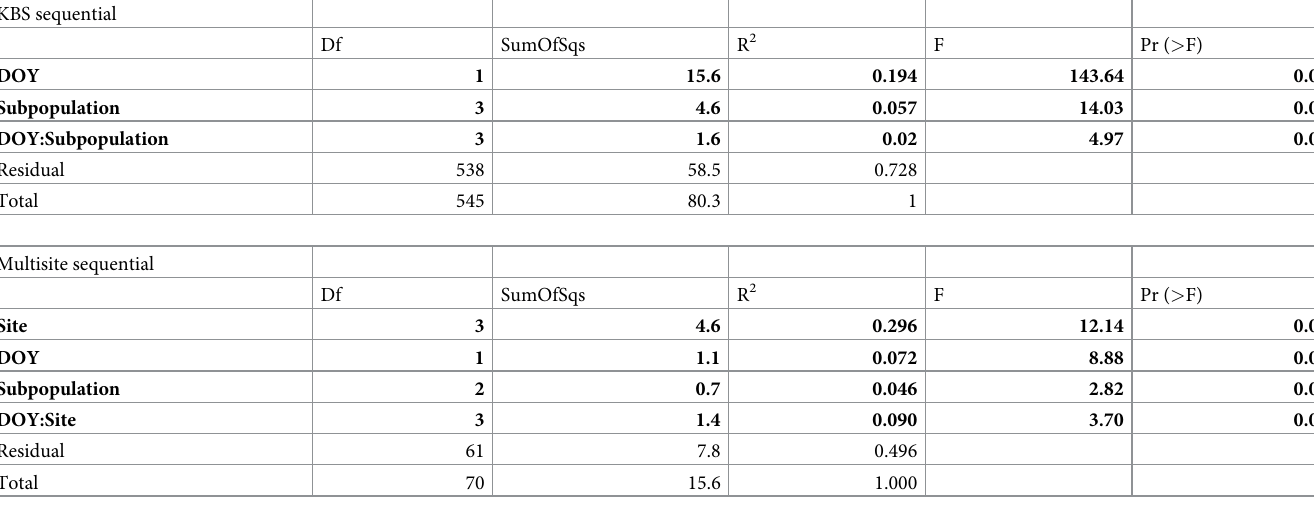
DOY is sampling date, subpopulation indicates genetic group, and site indicates planting site. Terms are shown with sequential effects. All terms were significant with α < 0.05.